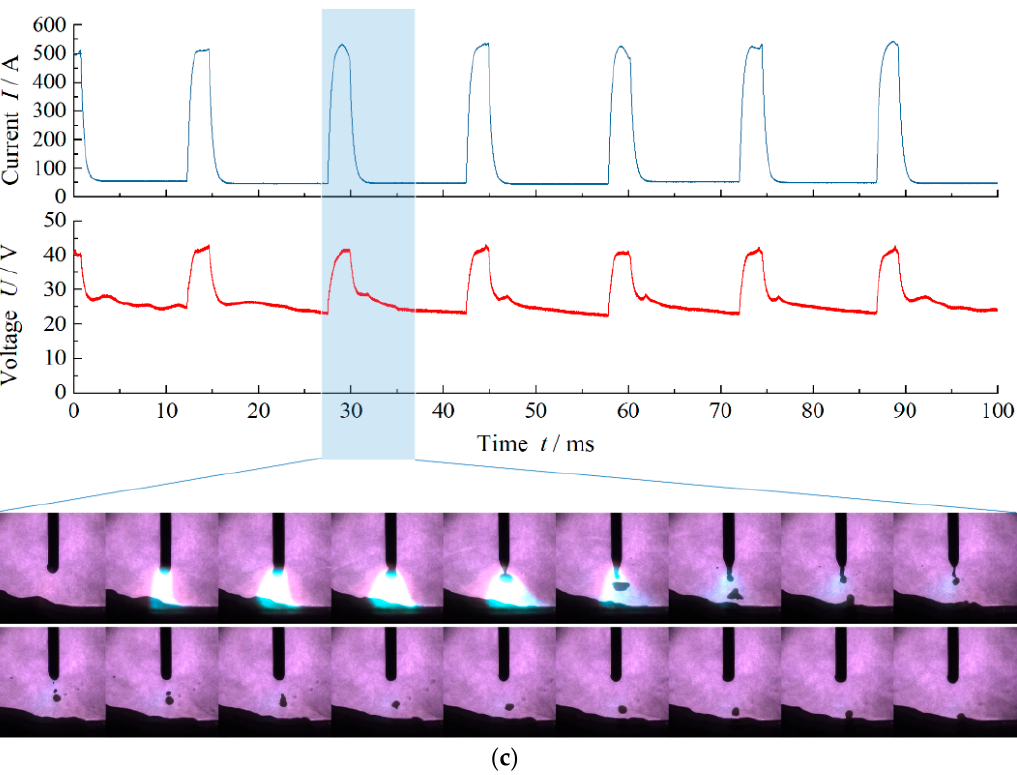
Figure 2. The waveforms and high-speed photographs of three typical modes of droplet transfer: ( a ) one drop per multiple pulses (ODMP); ( b ) one drop per pulse (ODPP); ( c ) multiple drops per pulse (MDPP).